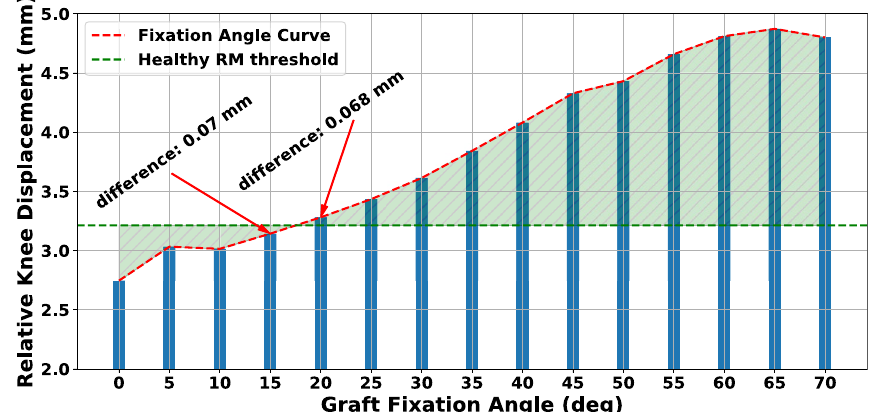
Figure 9. Effect of graft fixation angle on relative knee displacement. The “difference” term refers to the absolute difference in relative knee displacement between the ACLR FE model and the RM. It is noticed that for angles ◦ larger than 30 the relative knee laxity increases. In our case, we found the optimal fixation angles are between ◦ ◦ 15 and 20 .